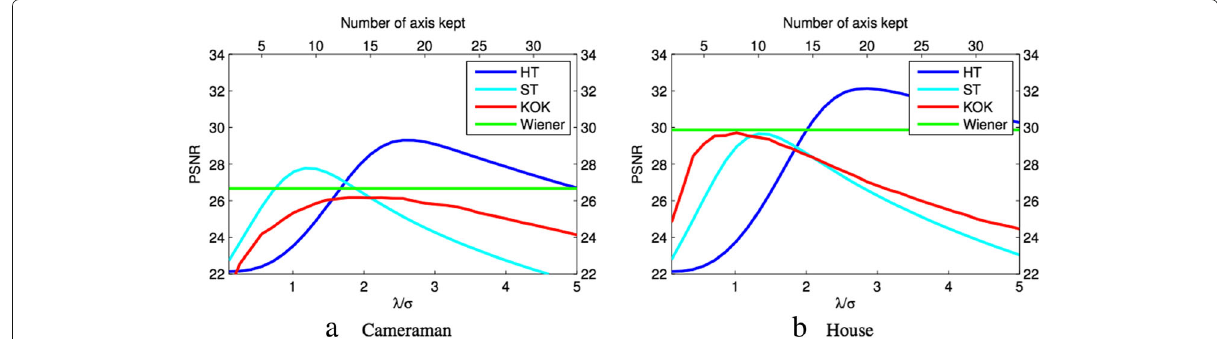
Fig. 7 Different PB-PCA projections: a comparison between PSNR of the different methods of the projections in PB-PCA for the House and Cameraman images. The threshold ratio ( λ / σ ) into the bottom of x -axis controls the number of axes kept in the upper x -axis. σ is the noise variation, and λ is chosen by cross validation